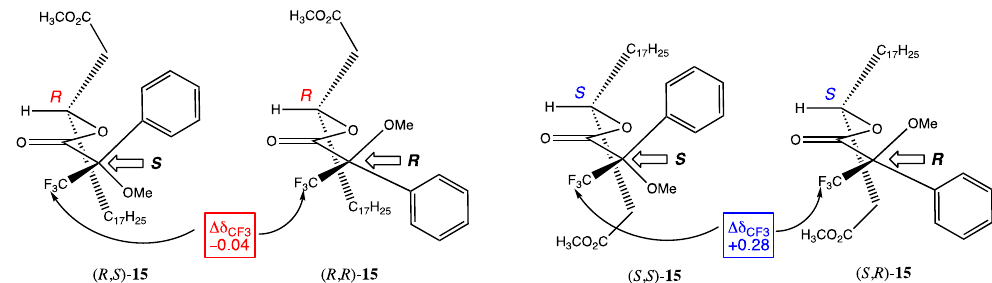
Figure 3. Assignment of configuration based on the Mosher ester analysis.